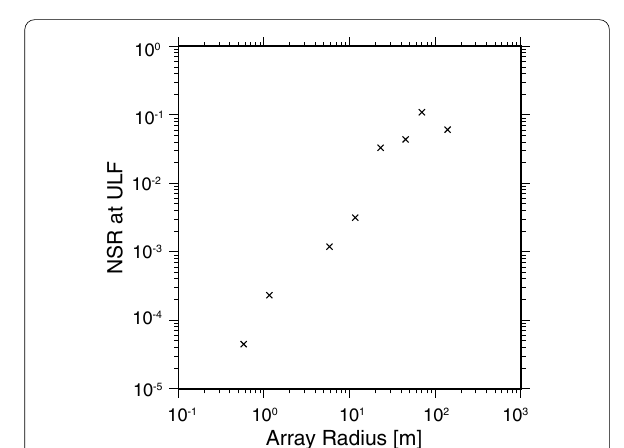
Fig. 12 Relation between array radius and NSR at ULF. The data of this study (Fig. 10) are